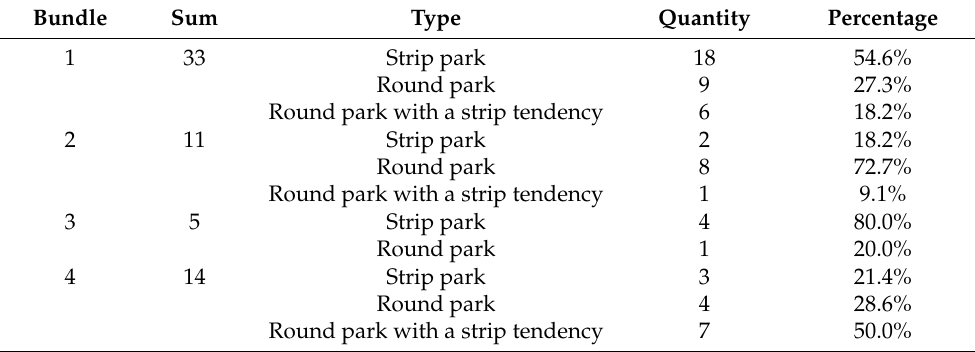
Table 3. Classification of 63 different forms of park cooling